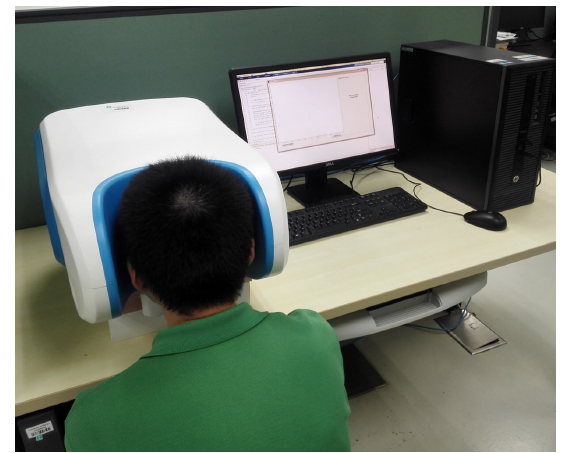
Figure 4. A simulation of an individual using this device.